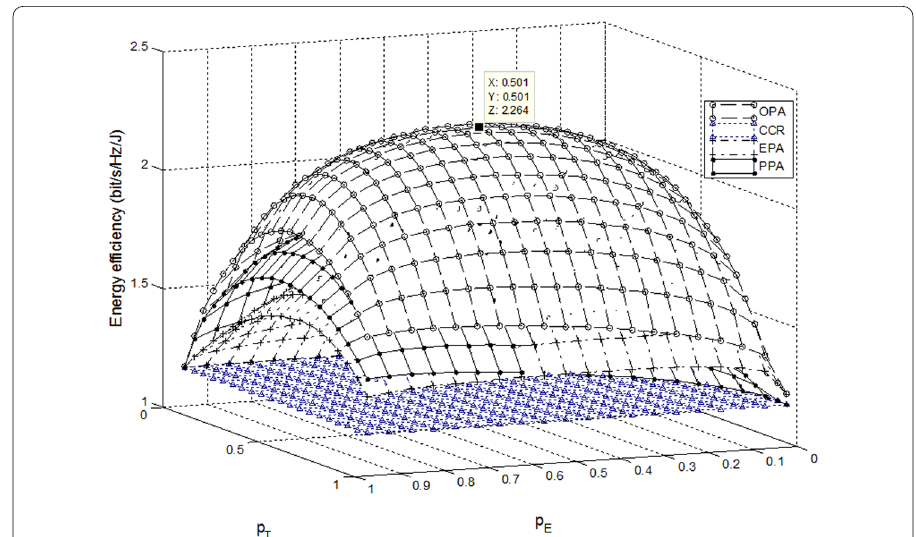
Fig. 4 Energy efficiency for NSCRS with OPA, PPA, and EPA compared to CCR